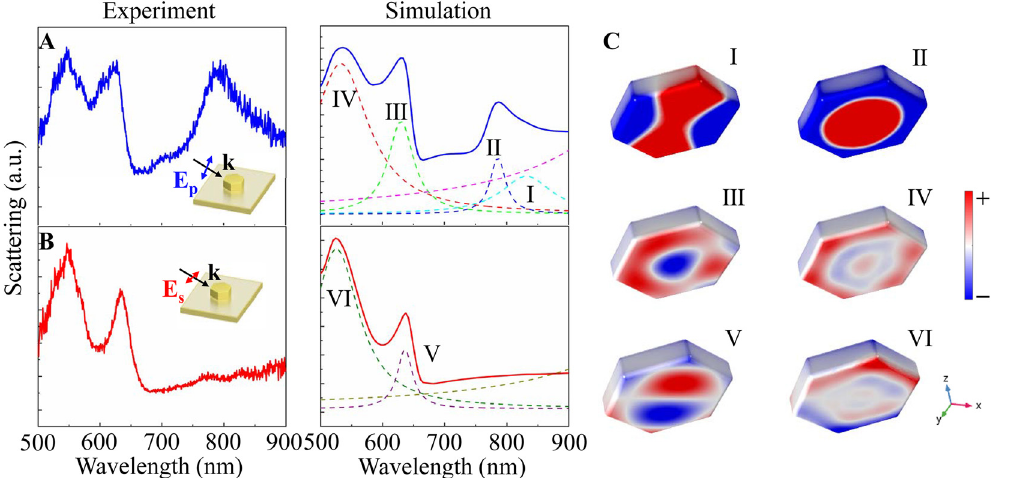
Figure2: Experimental(leftcolumn)andsimulated(rightcolumn)scatteringspectraofhexagonalAuNPoM( d =185nm, g =5nm)illuminated by (A) p-polarized and (B) s-polarized beams. (C) Charge density distributions of modes I – VI with spectral positions labeled in (A) and